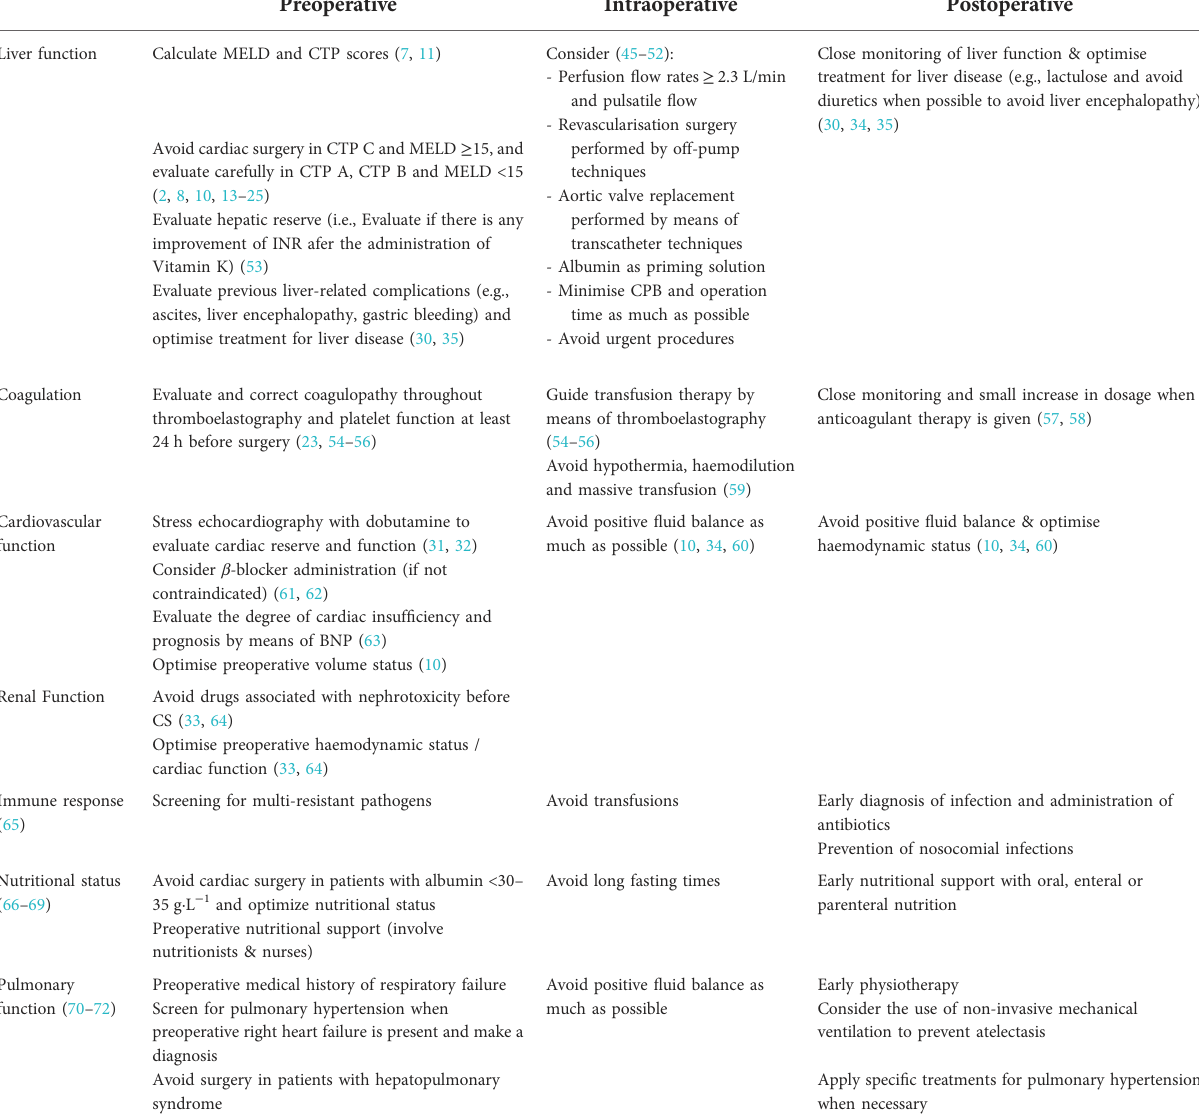
TABLE 5 Speci fi c recommendations for the perioperative management of patients with liver disease who undergo cardiac surgery. Preoperative